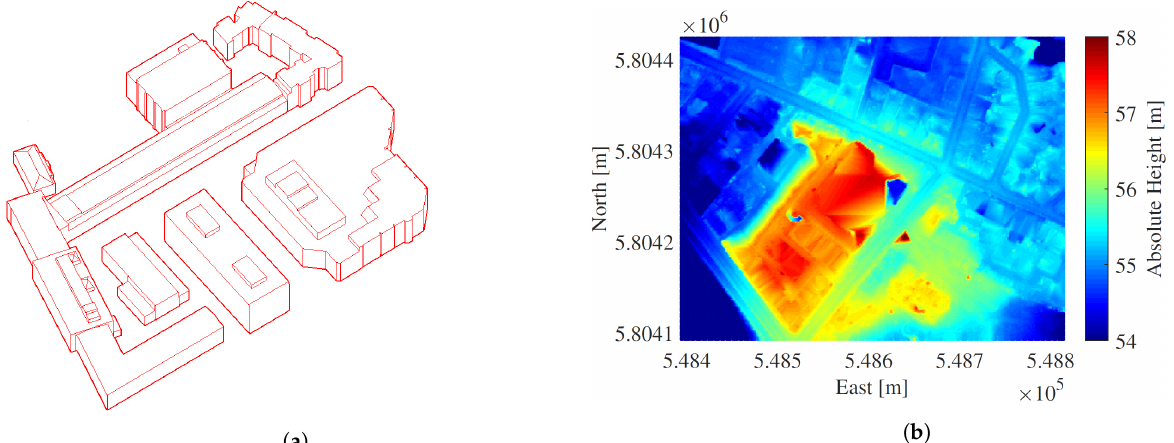
Figure 9. Object information of the measured environment: ( a ) LoD-2 3D city model, and ( b ) DTM of the area